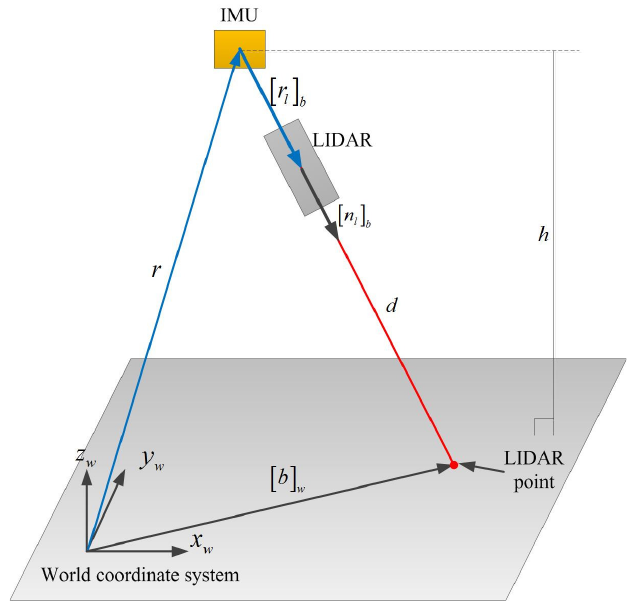
Figure 3. LIDAR calibration (the sensor unit is handheld while LIDAR is pointing at the floor for the